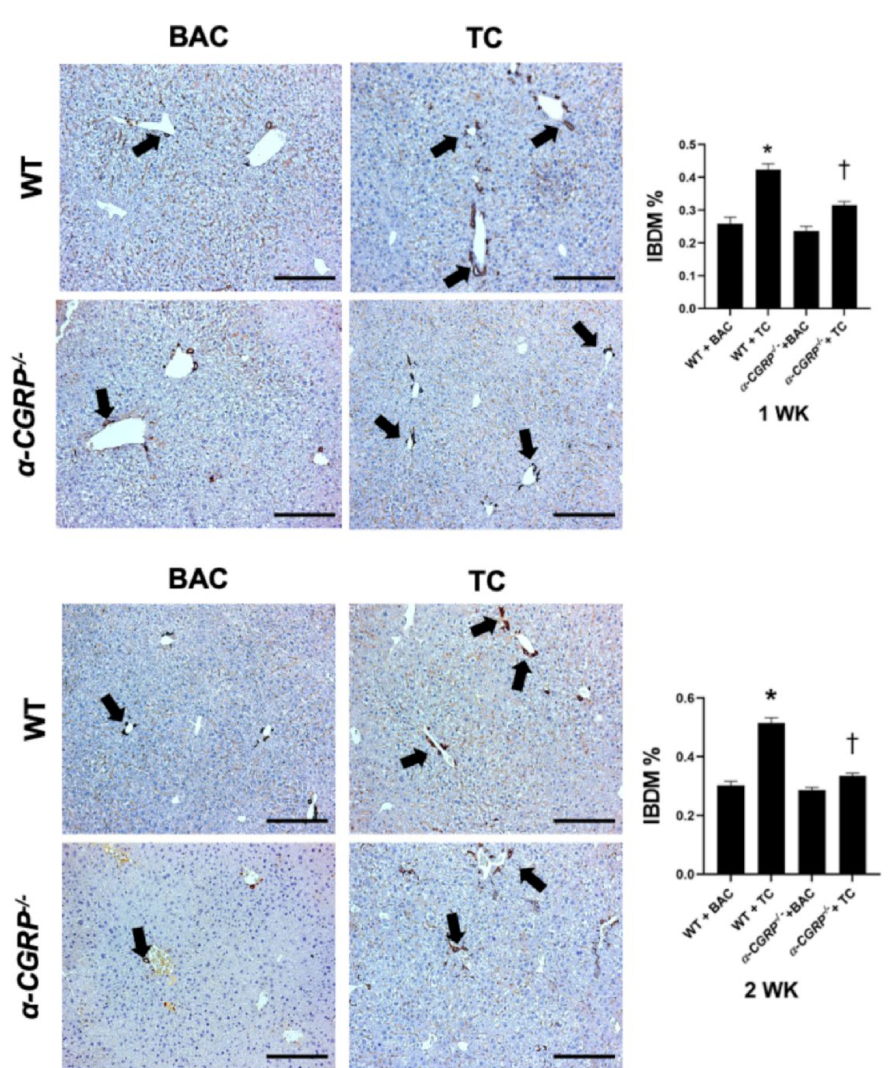
Figure 3. Knockout of α -CGRP decreases IBDM in mice fed with TC diet. In WT mice fed TC, there was a significant increase in IBDM compared to BAC-fed WT mice. TC did not increase IBDM in α -CGRP − / − compared to α -CGRP − / − mice fed BAC; no significant difference in IBDM was observed between normal WT and α -CGRP − / − treated with BAC. Black arrows show bile ducts. Original magnification 10 × ; scale bar 100 µ m Data are mean ± SEM of slides (completed scanned) from n = 3 different animals per groups. * < p value vs. WT + BAC; † < p value vs. WT +